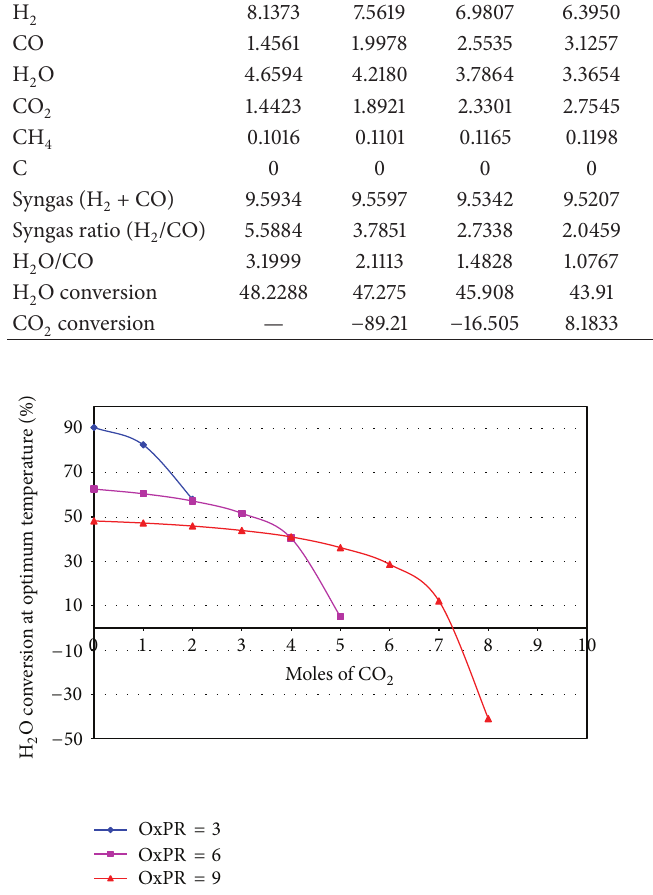
Figure 12: H 2 O conversion at optimum temperature in CR of